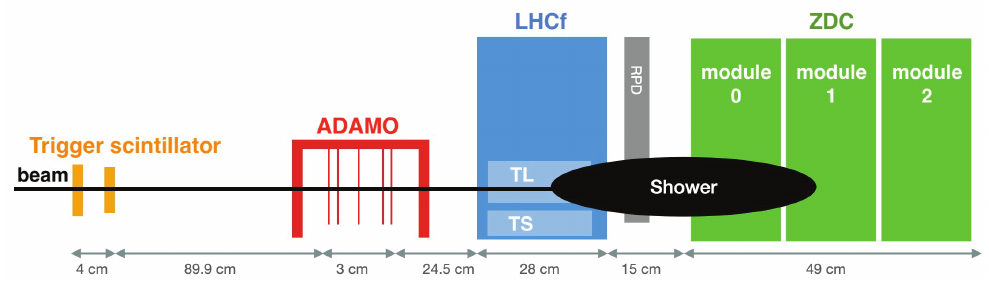
Figure 1. Experimental setup of the beam test. Beams were injected from the left-hand side, and they passed through trigger scintilla- tors, ADAMO, LHCf, and ZDC in that